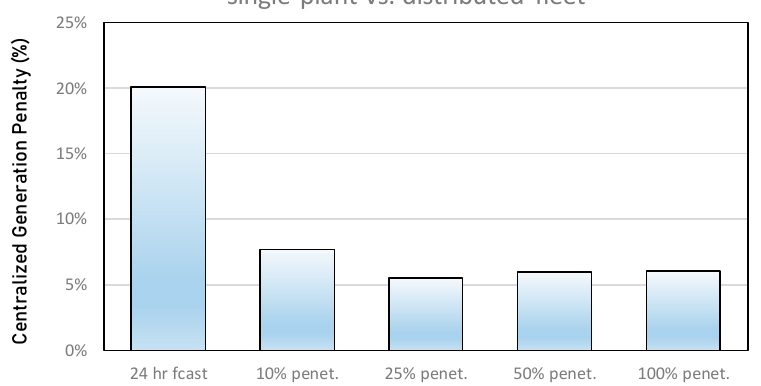
Figure 13. The centralized generation LCOE premium as a function of firmness requirements from 24-h forecasts with firm power generation.